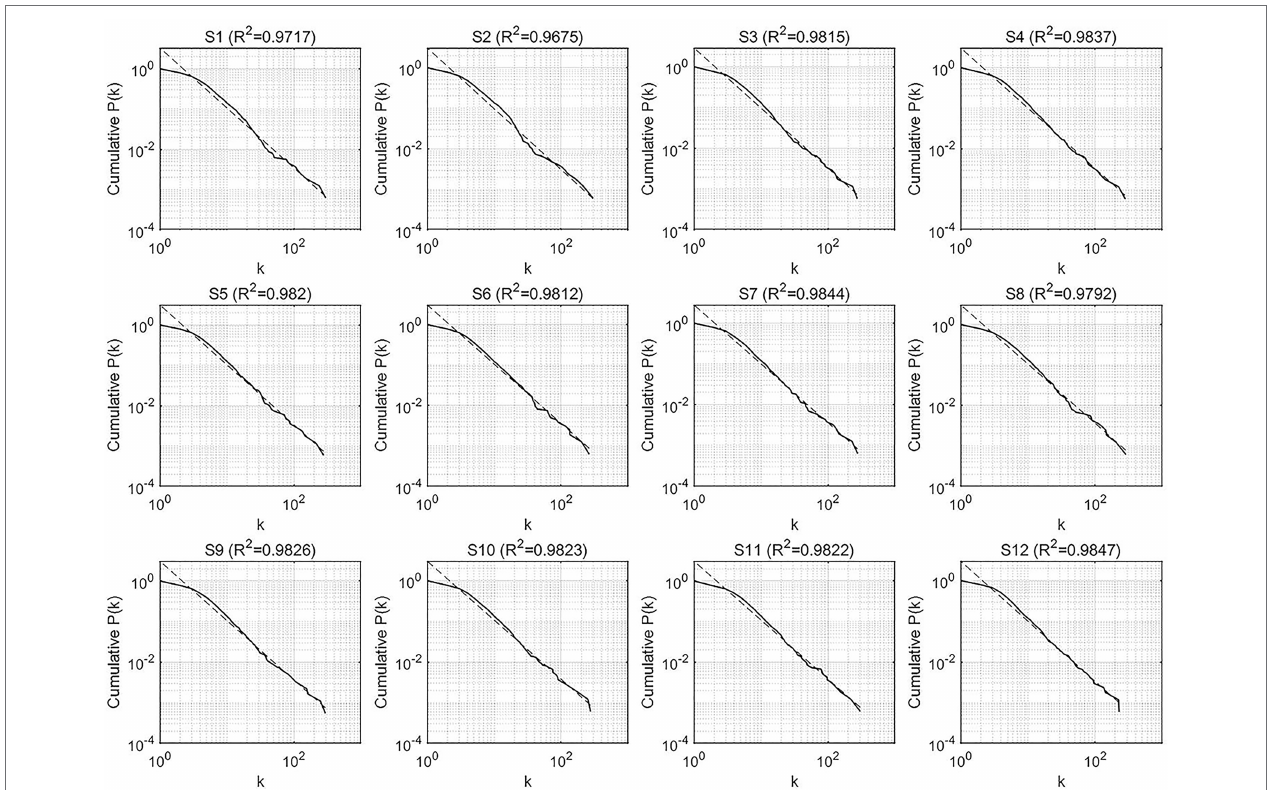
FIGURE 4 | The cumulative degree distributions of the syntactic dependency networks of CI